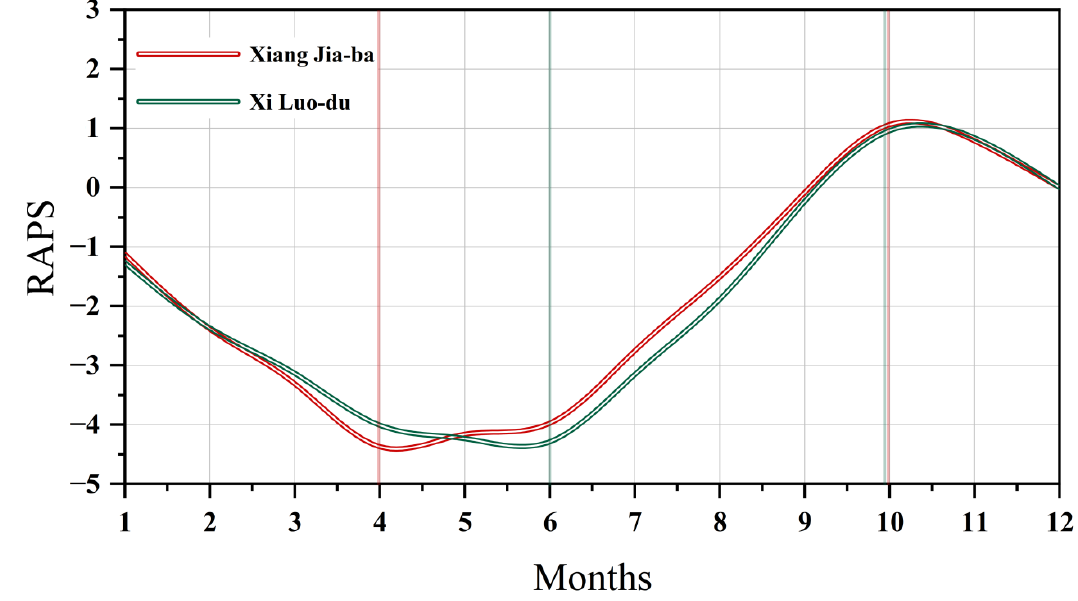
Figure 4. PAPS of obtained time series of power output.